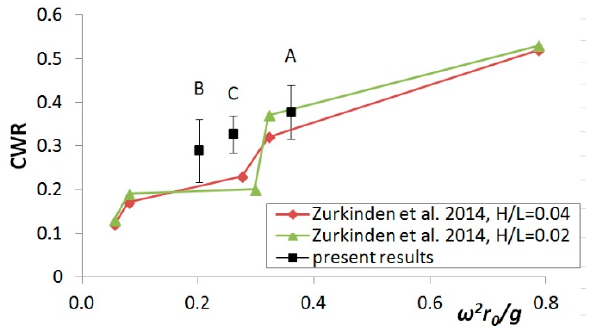
Figure 12. CWR as a function of wave dimensionless frequency. Wave A: H / L = 0.03; wave B: H / L = 0.02; wave C: H / L = 0.03.